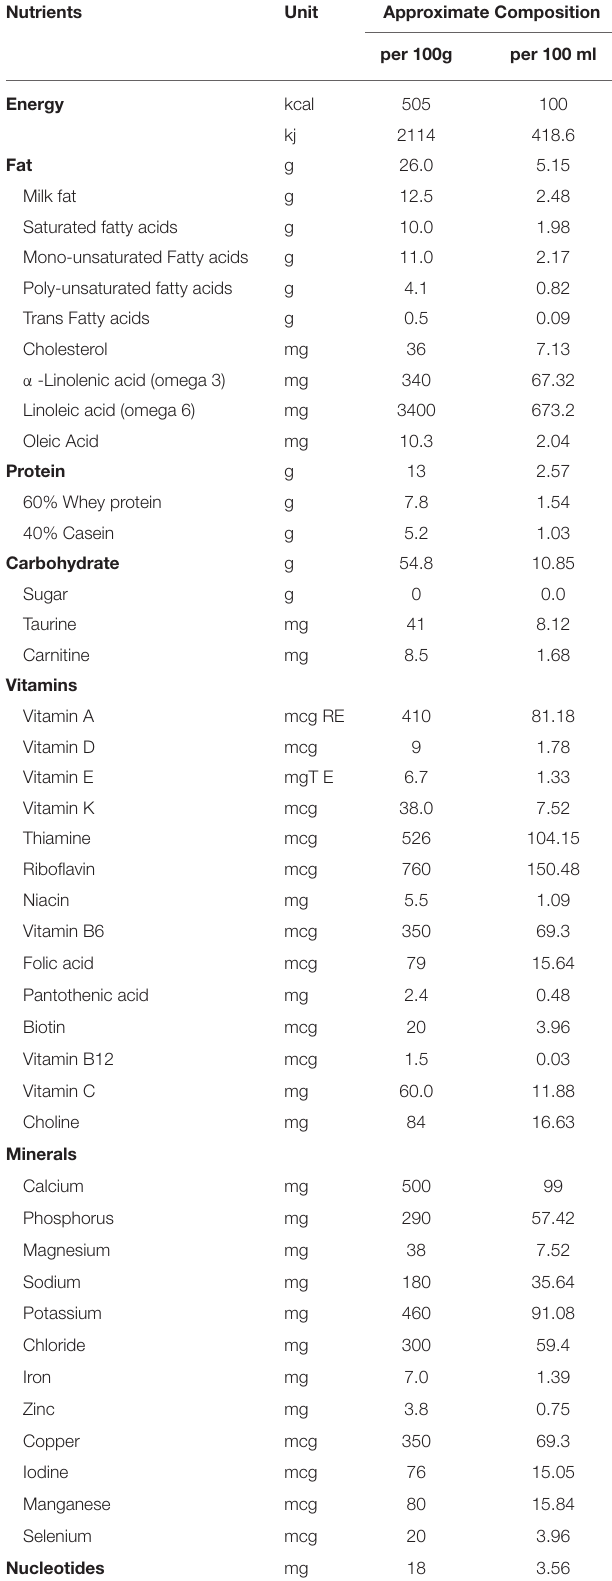
TABLE 1 | Energy and nutrient dense formula, ingredient